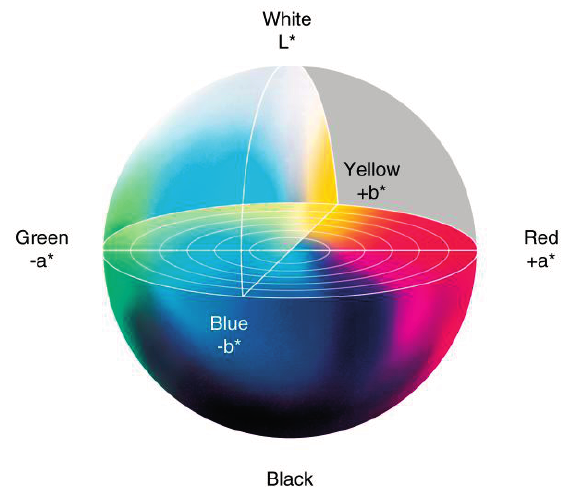
Figure 2. CIE LAB 1976 color